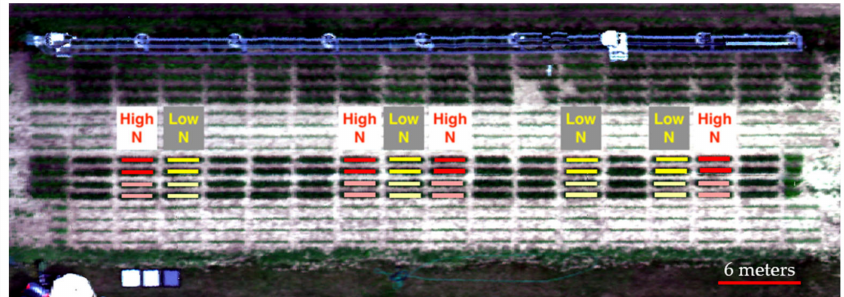
Figure 8. Reconstructed RGB image from hyperspectral data along with corresponding treatment.